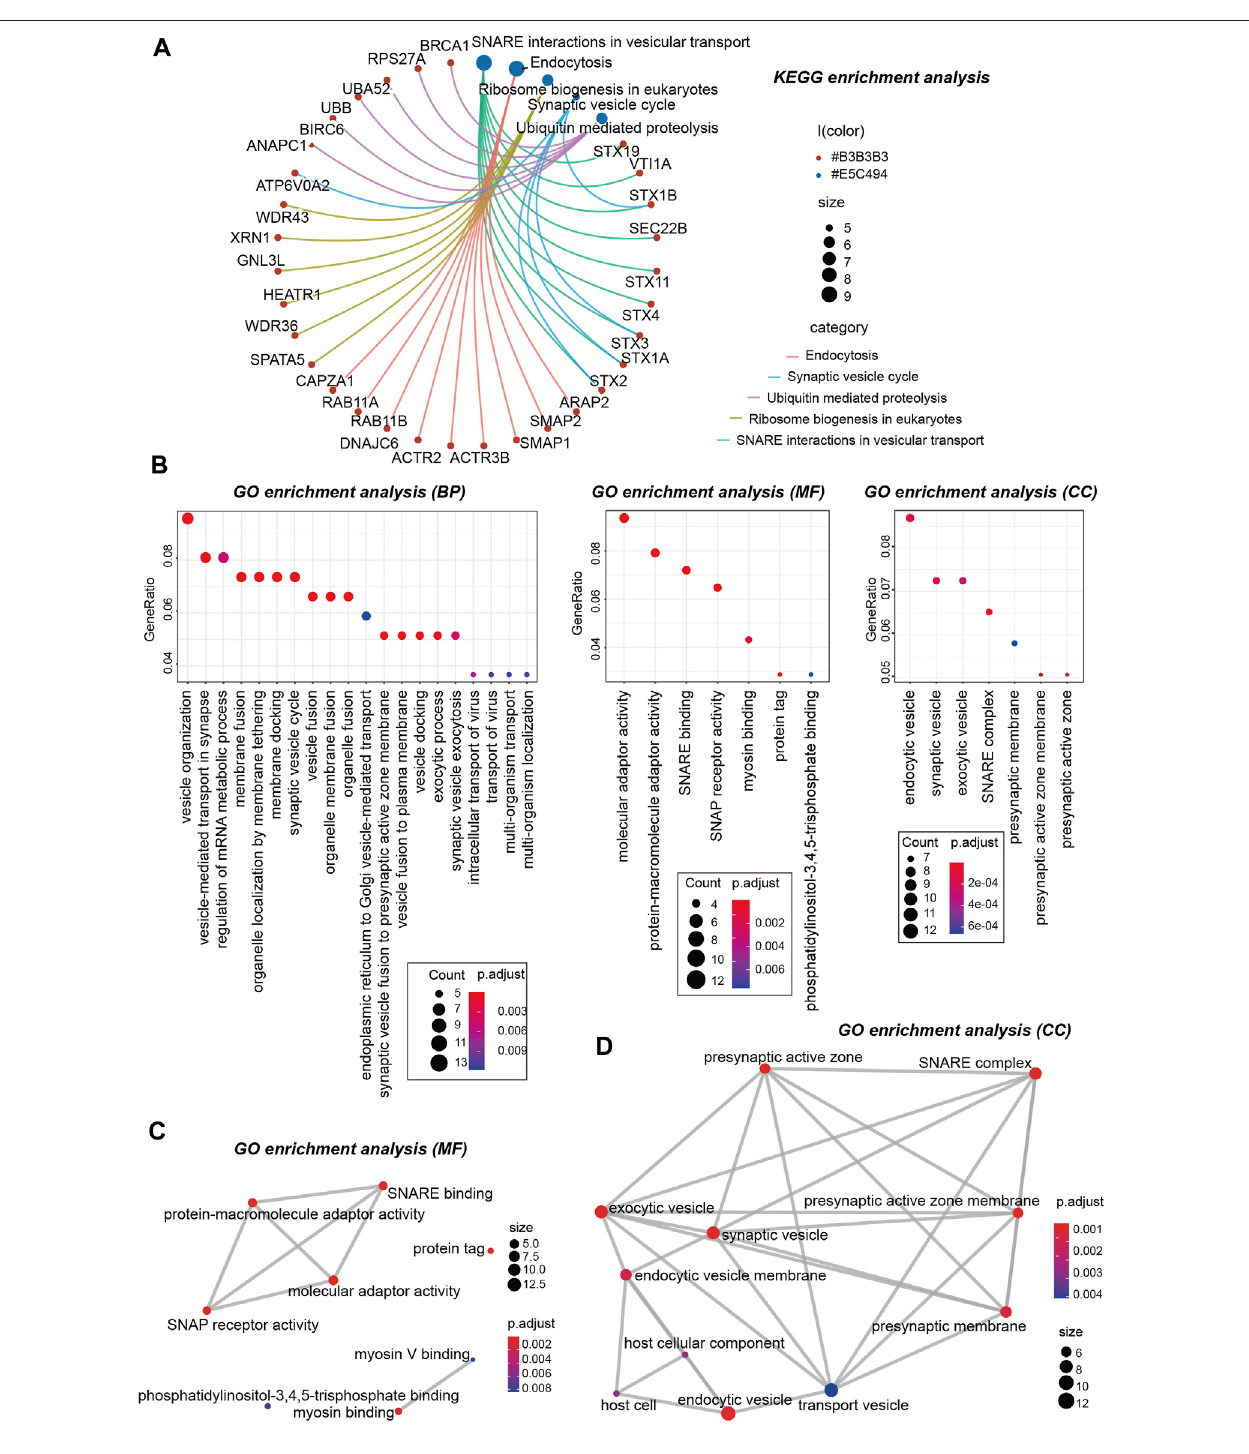
FIGURE 13 | KEGG and GO analyses-biological process (BP)/cellular component (CC)/molecular function (MF) of OSBPL3-related genes in tumors. (A) cnetplot for the KEGG analysis. (B) Bubble diagram of GO enrichment analysis. (C – D) GO enrichment analysis-MF (C) and CC (D) were performed.